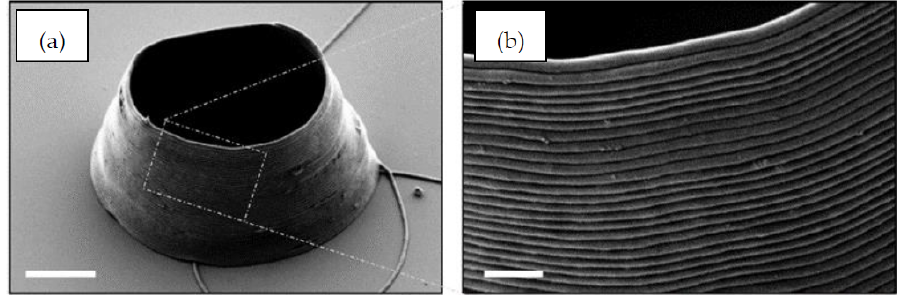
Figure 40. A cylindrical microstructure printed using EHD jetting with a novel electrostatic deflection system. The part was fabricated from polyethylene oxide (PEO) ink and achieved a submicron feature size without the use of supports. Here, a scale bar of ( a ) 5 μ m and ( b ) 1 μ m are used to image the microstructure [164].